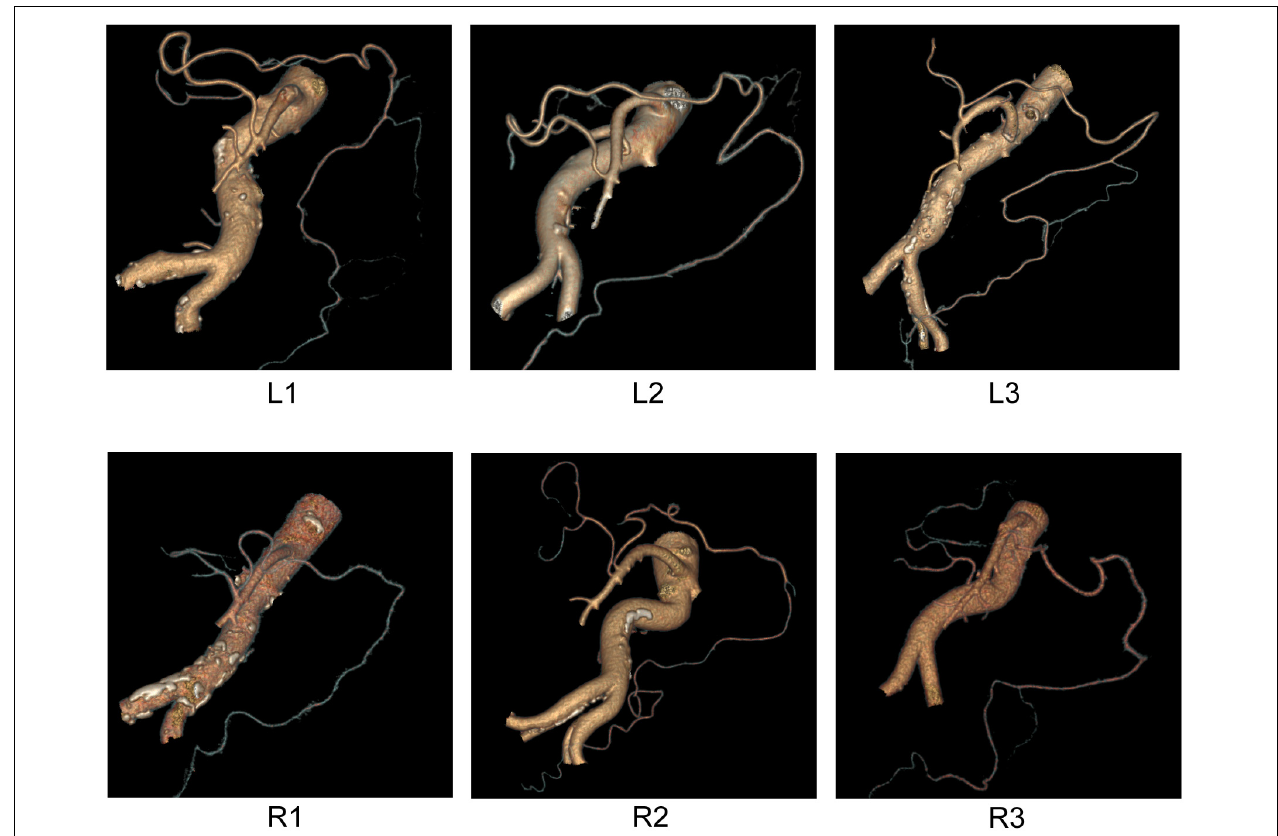
FIGURE 5 | The blood flow pathway after high ligation. The collateral circulation (compensatory pathway) evolved from the shortcut anastomotic branches.